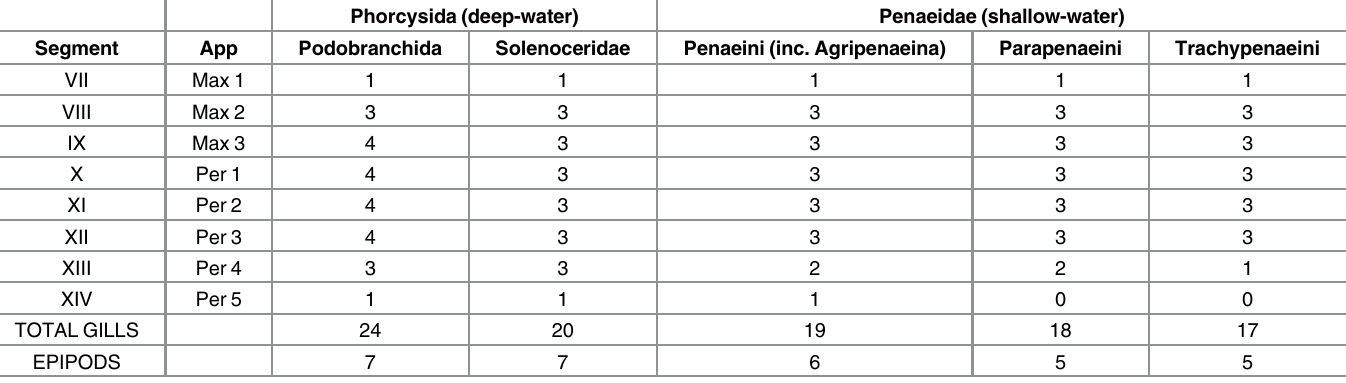
Table 1. Gills and epipods in Penaeoidea. Among the shallow-water clades, Agripenaeina (and other members of Penaeini) have the highest number of gills and epipods. Deep-water clades have the highest numbers across all of Penaeoidea. Listed are the total numbers of gills and epipods per side, based on the ancestral states for each clade, using parsimony. App = associated appendix, Max = maxilliped, Per =